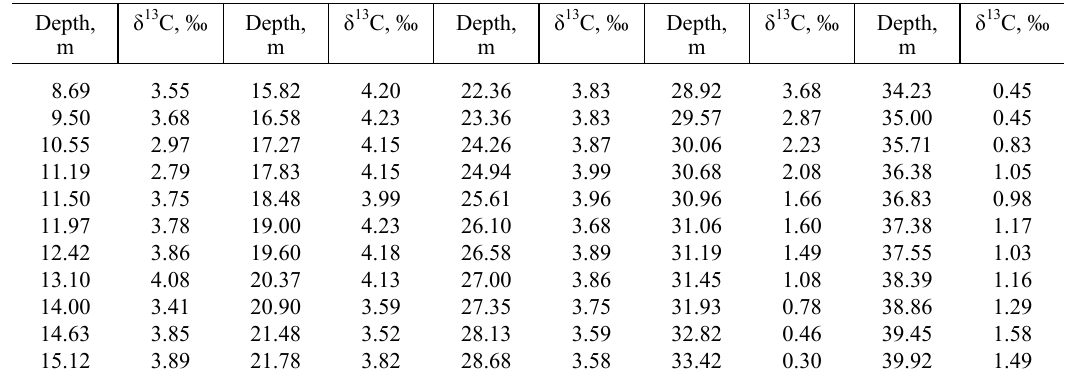
Table 2. Carbon isotope data from the Suigu (S-3) core section Depth,